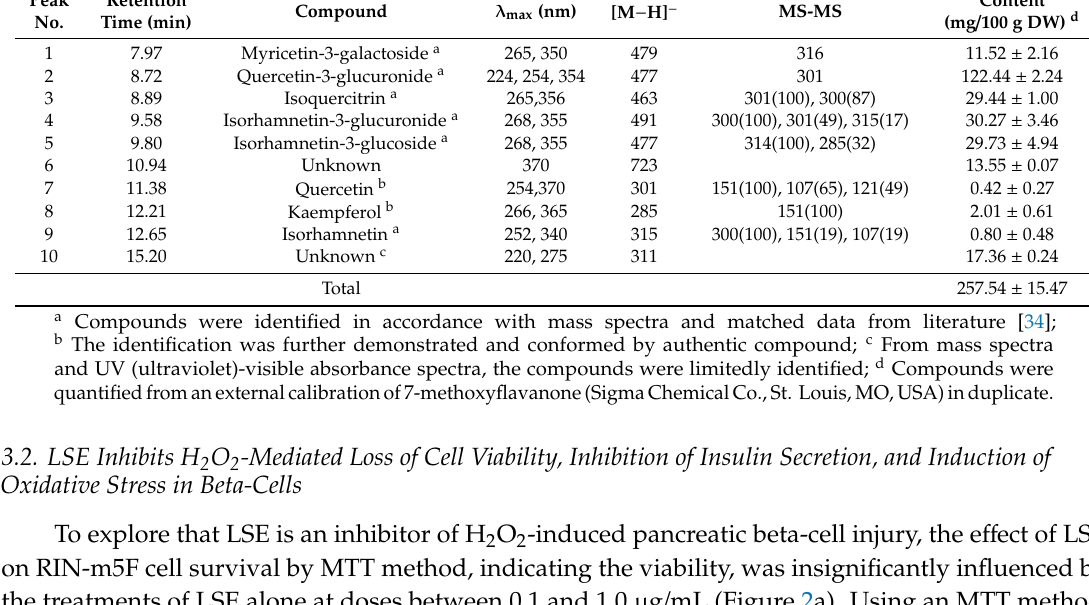
Table 1. Identification of the compositions of lotus seedpod aqueous extracts (LSE) by HPLC-DAD (high-performance liquid chromatography-diode array detector), LC-MS (liquid chromatography–mass spectrometry), and LC-MS-MS (liquid chromatography-tandem mass spectrometry) analysis. Peak